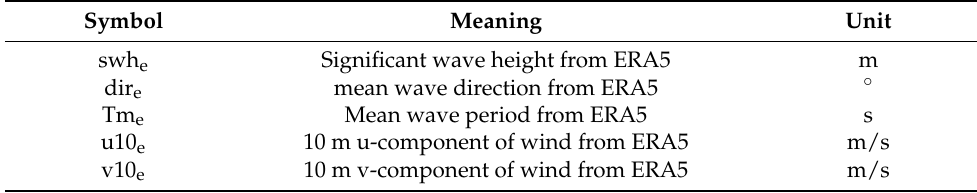
Table 2. List of external source parameters for the calibration of the dominant wavelength.